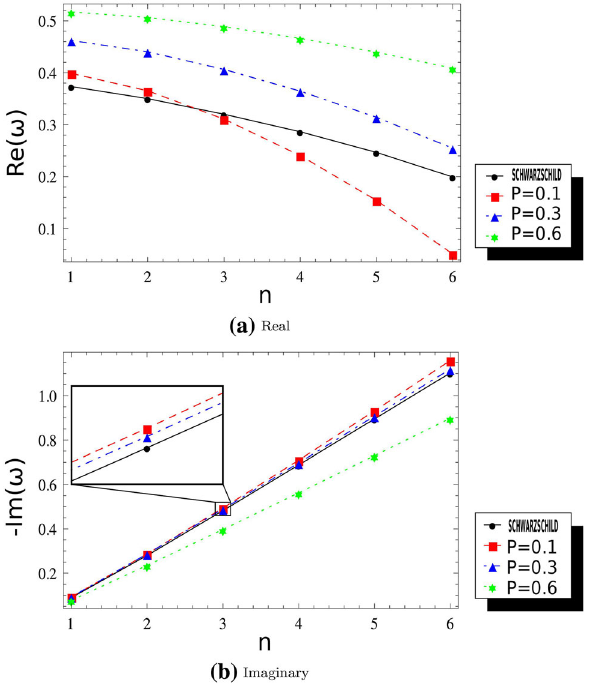
Fig. 4 Behavior of the quasinormal modes, a real part and b imaginary part of ω for l = 2 and P = 0 . 1 , 0 . 3 , 0 .